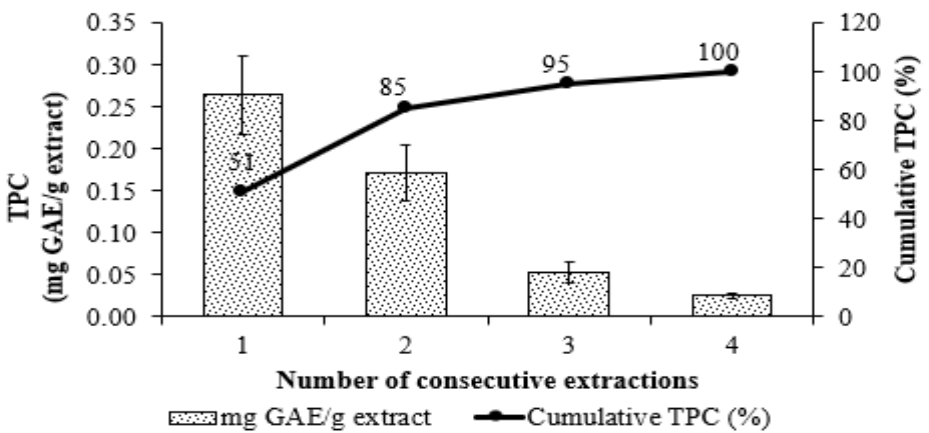
Figure 1. Total phenolic content (mg GAE/g extract) in the RBP extracts and cumulative percentage of total phenolic content in the consecutive extractions.